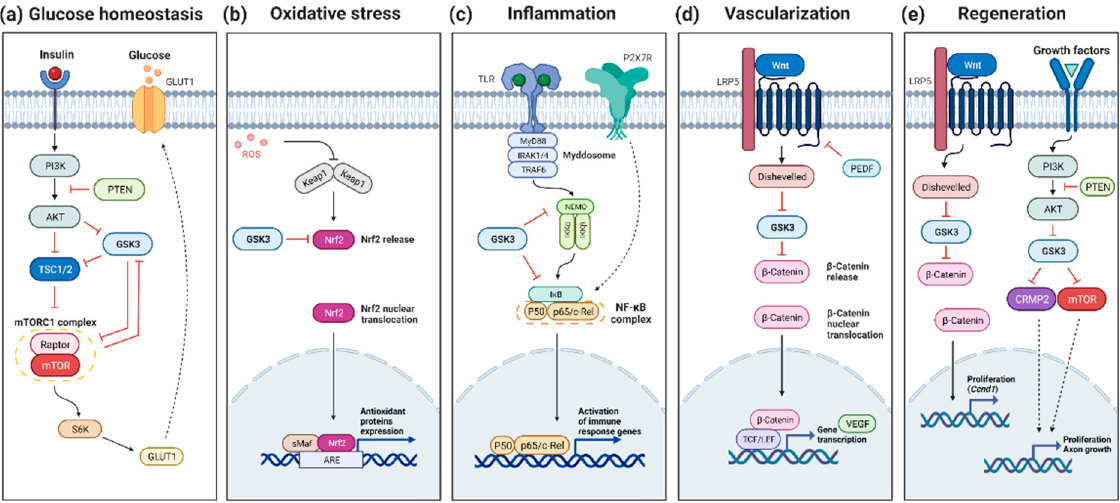
Figure 1. GSK3 regulatory function in different signaling pathways. ( a ) GSK3 regulates glucose homeostasis through the inhibition of TSC1/2 and Raptor/mTOR complex. ( b ) Nrf2 release, mediating the oxidative stress response, is inhibited by GSK3. ( c ) GSK3 regulates inflammation through the phosphorylation of NF- κ B and upstream effectors. ( d ) Wnt signaling pathway activation induces VEGF expression and as such positively regulates vascularization. ( e ) Release of GSK3 inhibition following Wnt and growth factors addition enhances regeneration through Ccnd1 induction and mTOR/CRMP2 signaling, respectively. Created with BioRender.com.